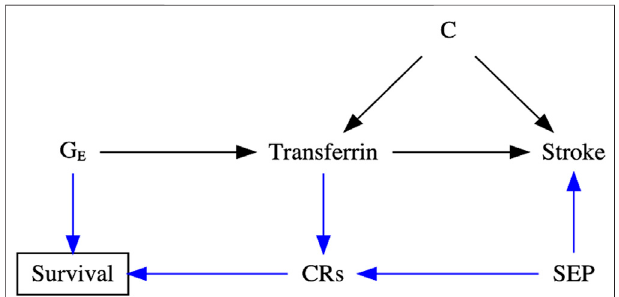
FIGURE 2 | Directed acyclic graph (DAG) illustrating the possible data- generating process underlying selection bias in the transferrin – stroke association due to missing people in the presence of competing risks (CRs, e.g., coronary artery disease) caused by the shared confounder [e.g., socioeconomic position (SEP)] of stroke and CRs in two-sample Mendelian randomization settings. C: the unmeasured confounder of the transferrin – stroke association.